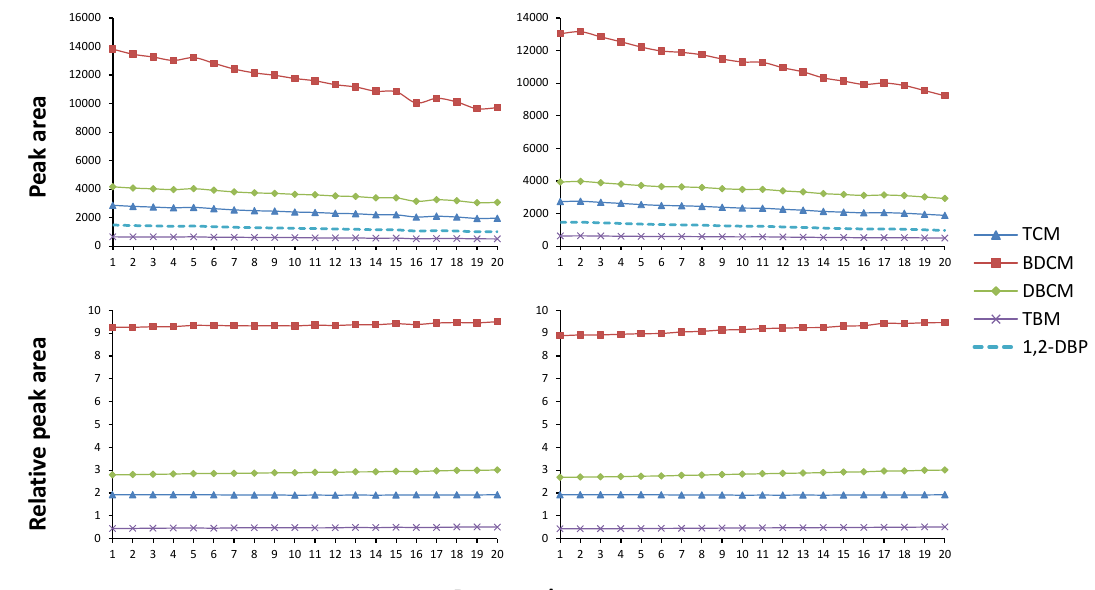
Figure 2. Consecutive runs of individual standards (each analyte 10 µg/L). Each sample was run 20 times in a row, with no interval between sample agitations ( left column ) and with 30 min intervals between agitations ( right column ). The upper plots show the peak area of each visible peak (four trihalomethanes (THMs) and internal standard) while the lower plots show the areas of the THMs when normalised to the internal